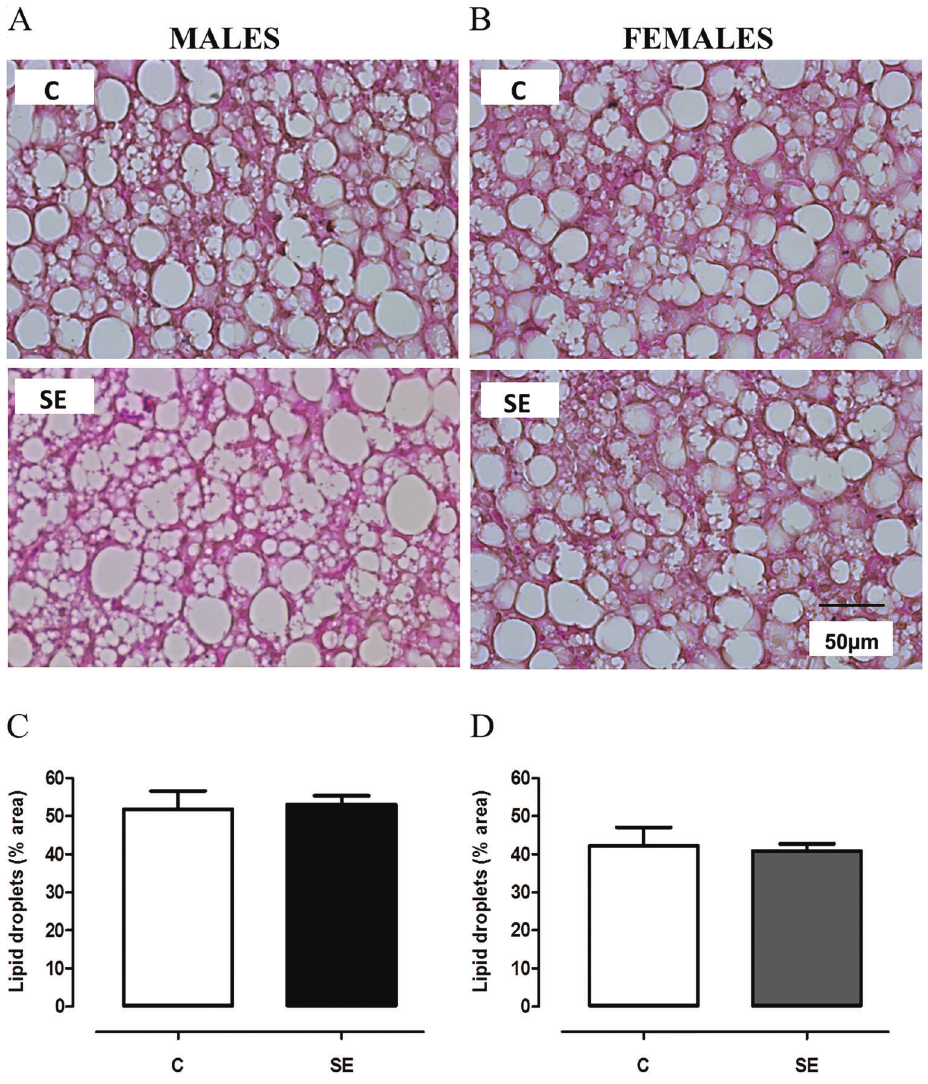
Figure 3. Long-term effects of neonatal cigarette smoke exposure on brown adipose tissue (BAT) morphology. Representative hematoxylin and eosin staining of BAT at 180 postnatal days in males ( A ) and females ( B ) (Scale bar: 50 m m). Quantitative analysis of the sectional areas of BAT lipid vacuoles is shown in males ( C ) and females ( D ). C: control group; SE: smoke-exposed group. Data are reported as means ± SE for n=6. There was gender effect, but there was no group effect for the lipid droplet sectional area (two-way